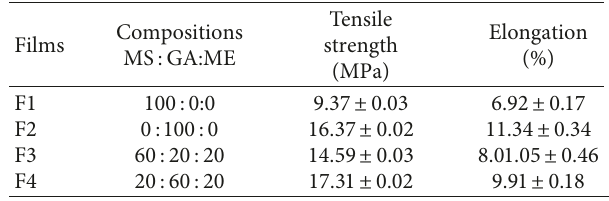
Table 3: Mechanical property of film.